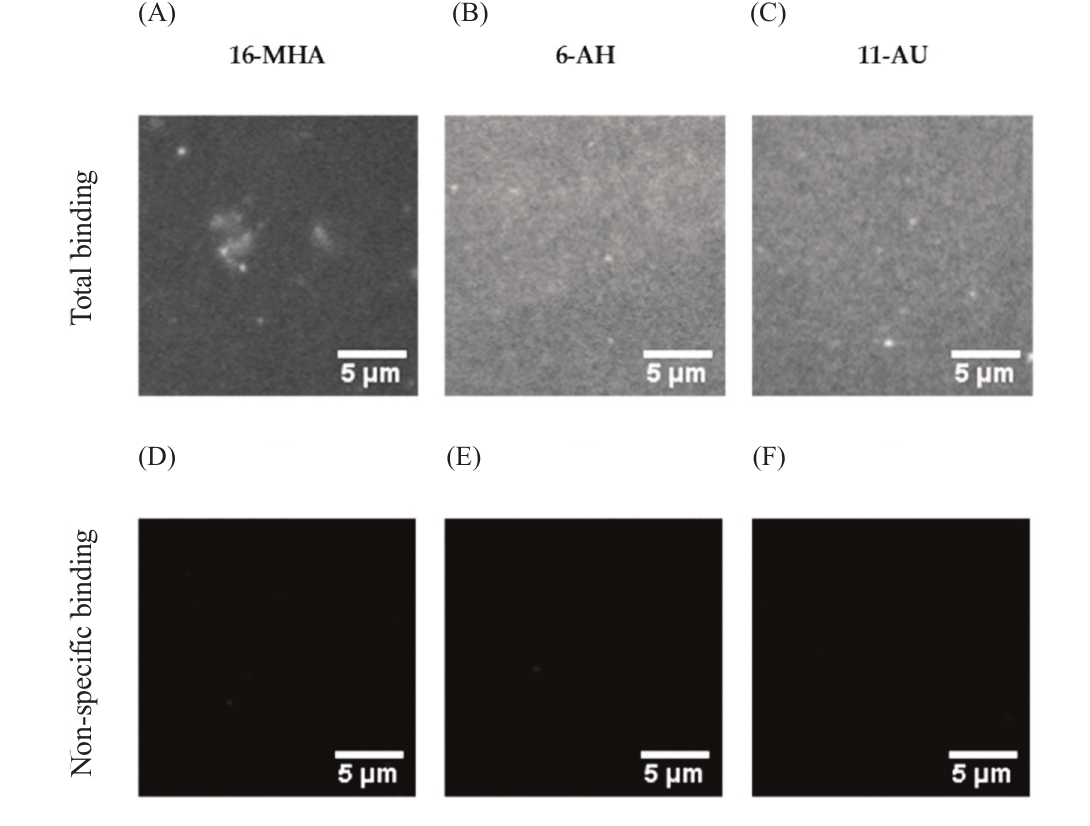
Fig. 4. TIRF images of Alexa 488­labelled anti­rabbit antibody binding to different electrodes. The biofunctionalized SAM layers were formed with 16­MHA (A, D), 6­AH (B, E) or 11­AU (C, F) and the spatial distribution of the total binding was measured in the presence of the capturing rabbit antibody (A­C), while the non­specific binding was detected in the absence of the capturing rabbit antibody (D­F). All TIRF images were taken in the presence of 10 nM anti­rabbit antibody labelled with Alexa 488 after 20 min incubation at room